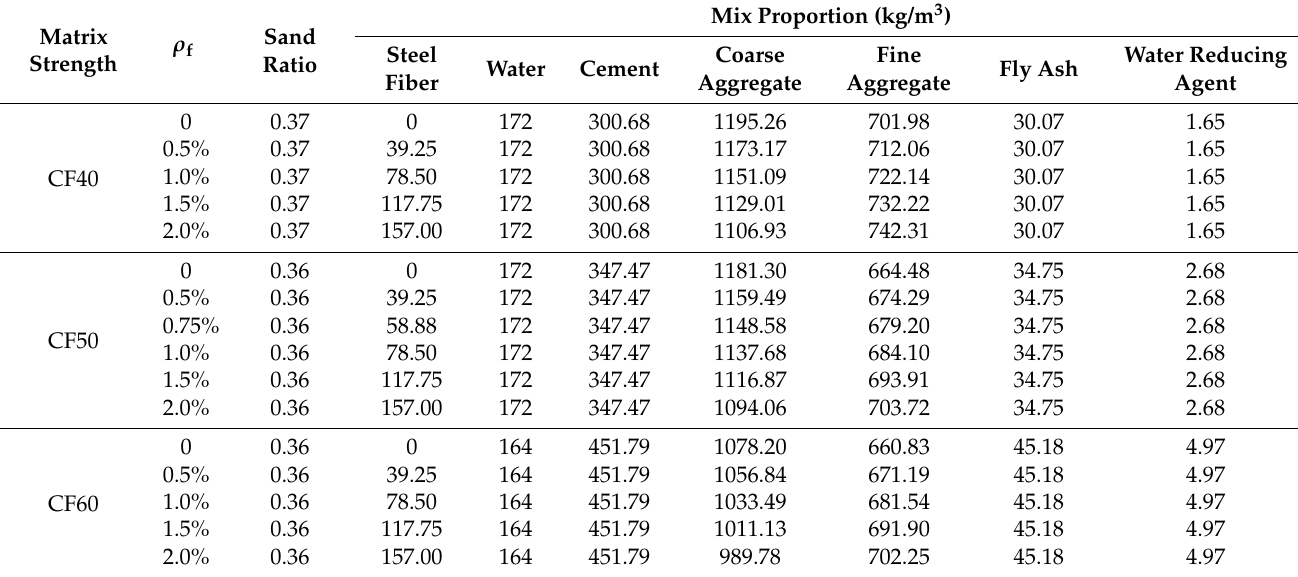
Table 3. Mixing proportions of steel-fiber-reinforced concrete.